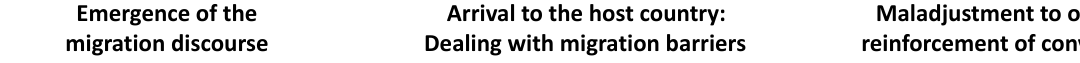
Table A2. Modification of subjectivities throughout the different stages of the migration